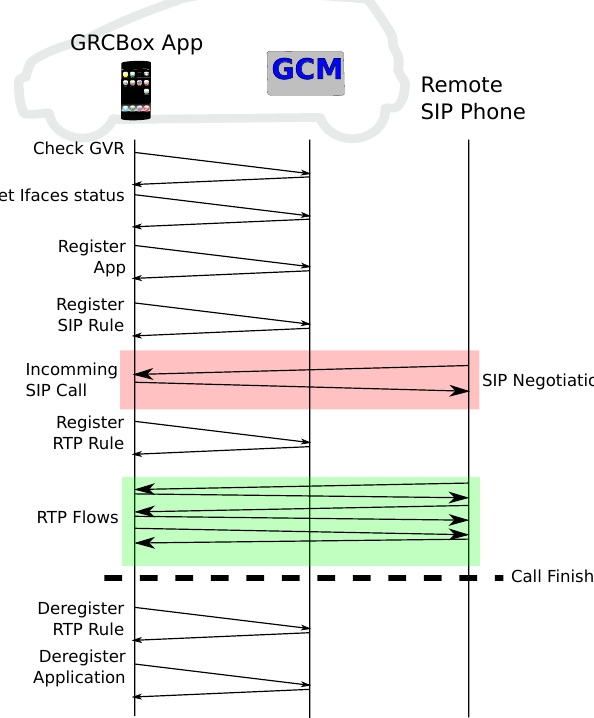
Figure 10: Example of a VoIP GRCBox